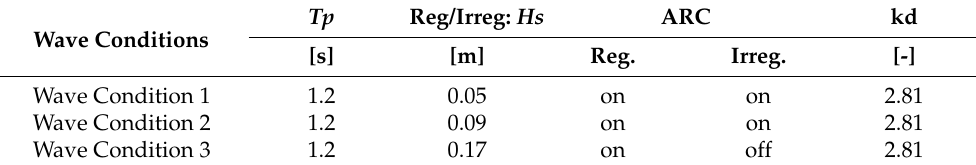
Table 1. Wave conditions used in the testing campaign for both regular (reg) and irregular (irreg) conditions. The ARC was switched off for higher irregular wave conditions due to limitations of the test facility. Tp Reg/Irreg: Hs ARC kd Wave Conditions [s] [m] Reg. Irreg. [-] Wave Condition 1 1.2 0.05 on on 2.81 Wave Condition 2 1.2 0.09 on on 2.81 Wave Condition 3 1.2 0.17 on off 2.81